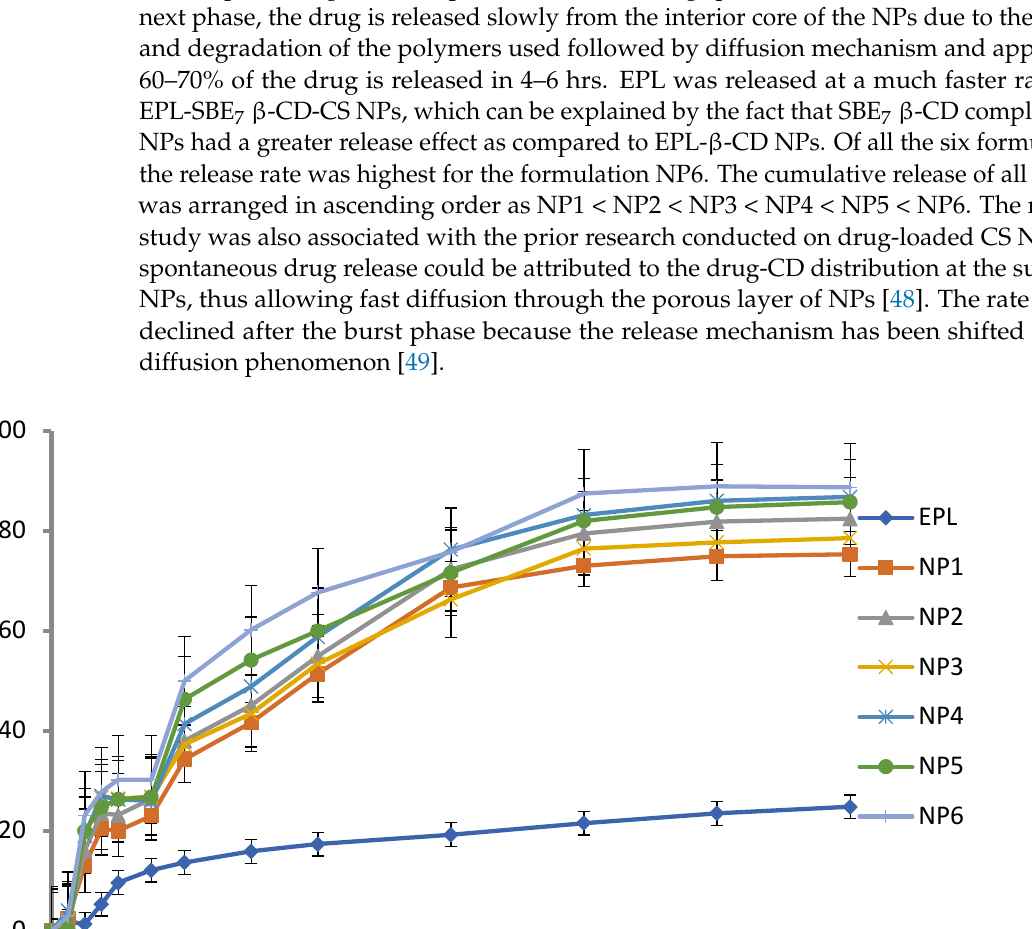
Table 6. Kinetic model of drug release from NPs. Formulation